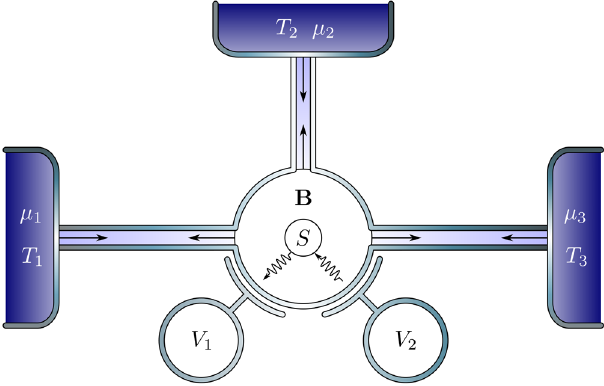
FIG. 1. Scattering approach to coherent transport. The figure shows a three-terminal conductor with two driving fields as a generic example for a multiterminal conductor. The system consists of a sample S , which is subject to a constant magnetic field B , and three reservoirs with chemical potentials μ 1 , μ 2 , μ 3 and temperatures T 1 , T 2 , T 3 . Each reservoir injects a beam of carriers, which consists of a thermal mixture of plane waves propagating toward the sample. At the sample, each incoming beam is scattered into three outgoing beams. The phase relation between incoming and outgoing carriers is preserved, while their energy can change due to the exchange of photons with the periodic driving fields V 1 and V 2